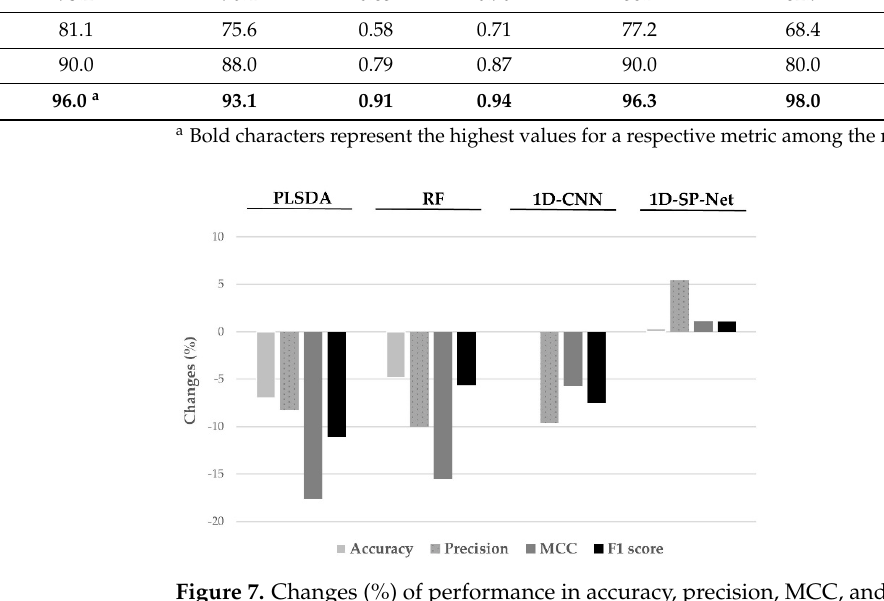
Figure 7. Changes (%) of performance in accuracy, precision, MCC, and F1 scores between training and testing results of the PLSDA, RF, 1D-CNN, and 1D-SP-Net models.